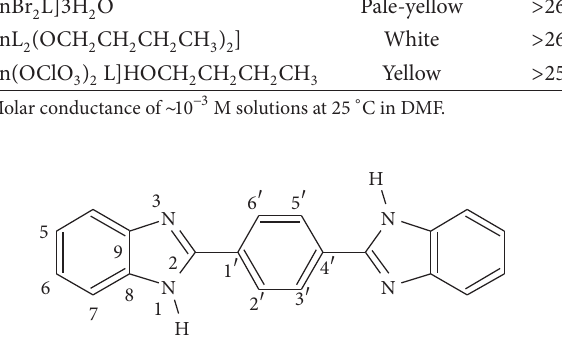
F 1: Structure of